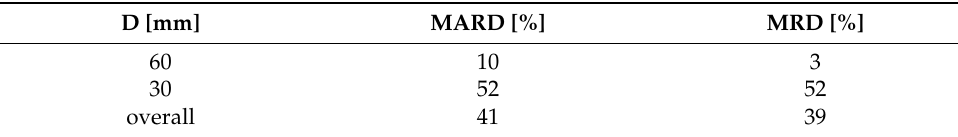
Table 1. MARD and MRD for the OLGA model for air–water flow.